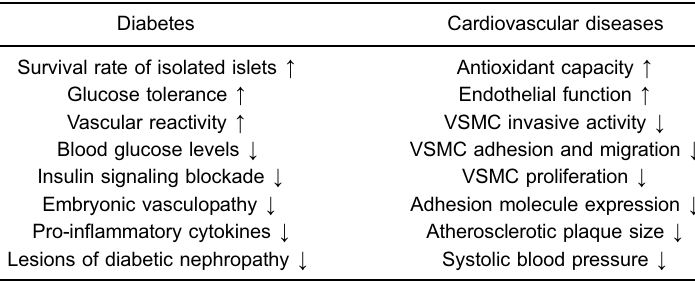
Pro-in fl ammatory cytokines k Atherosclerotic plaque size